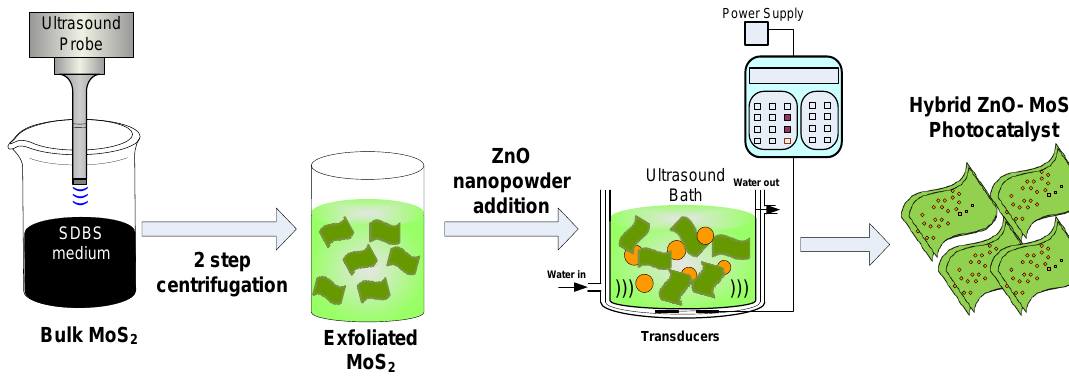
Figure 1. Schematic illustration of E-MoS 2 and hybrid ZnO-MoS 2 photocatalyst.